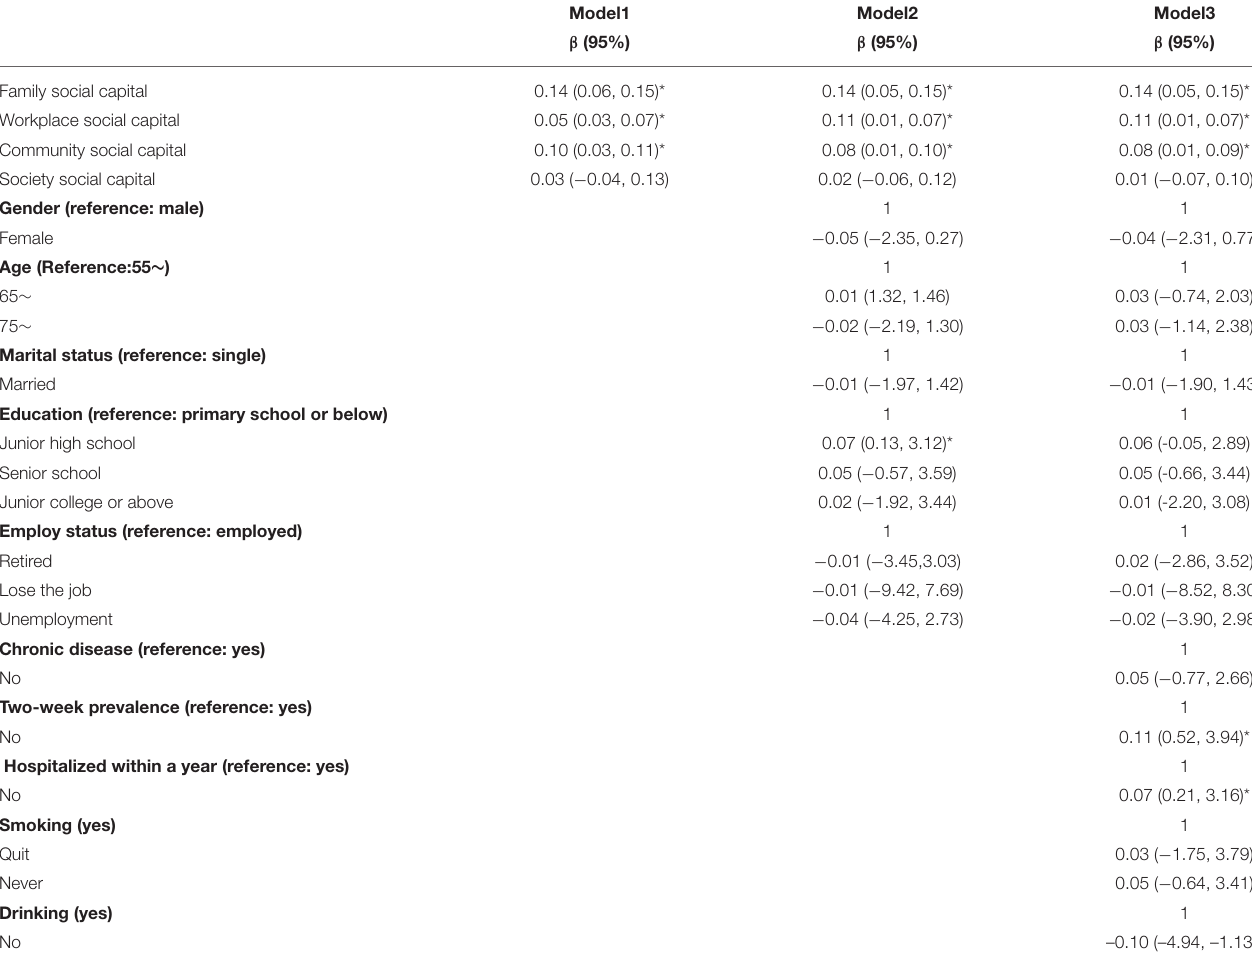
TABLE 2 | Linear regression analysis of association between social capital and subjective